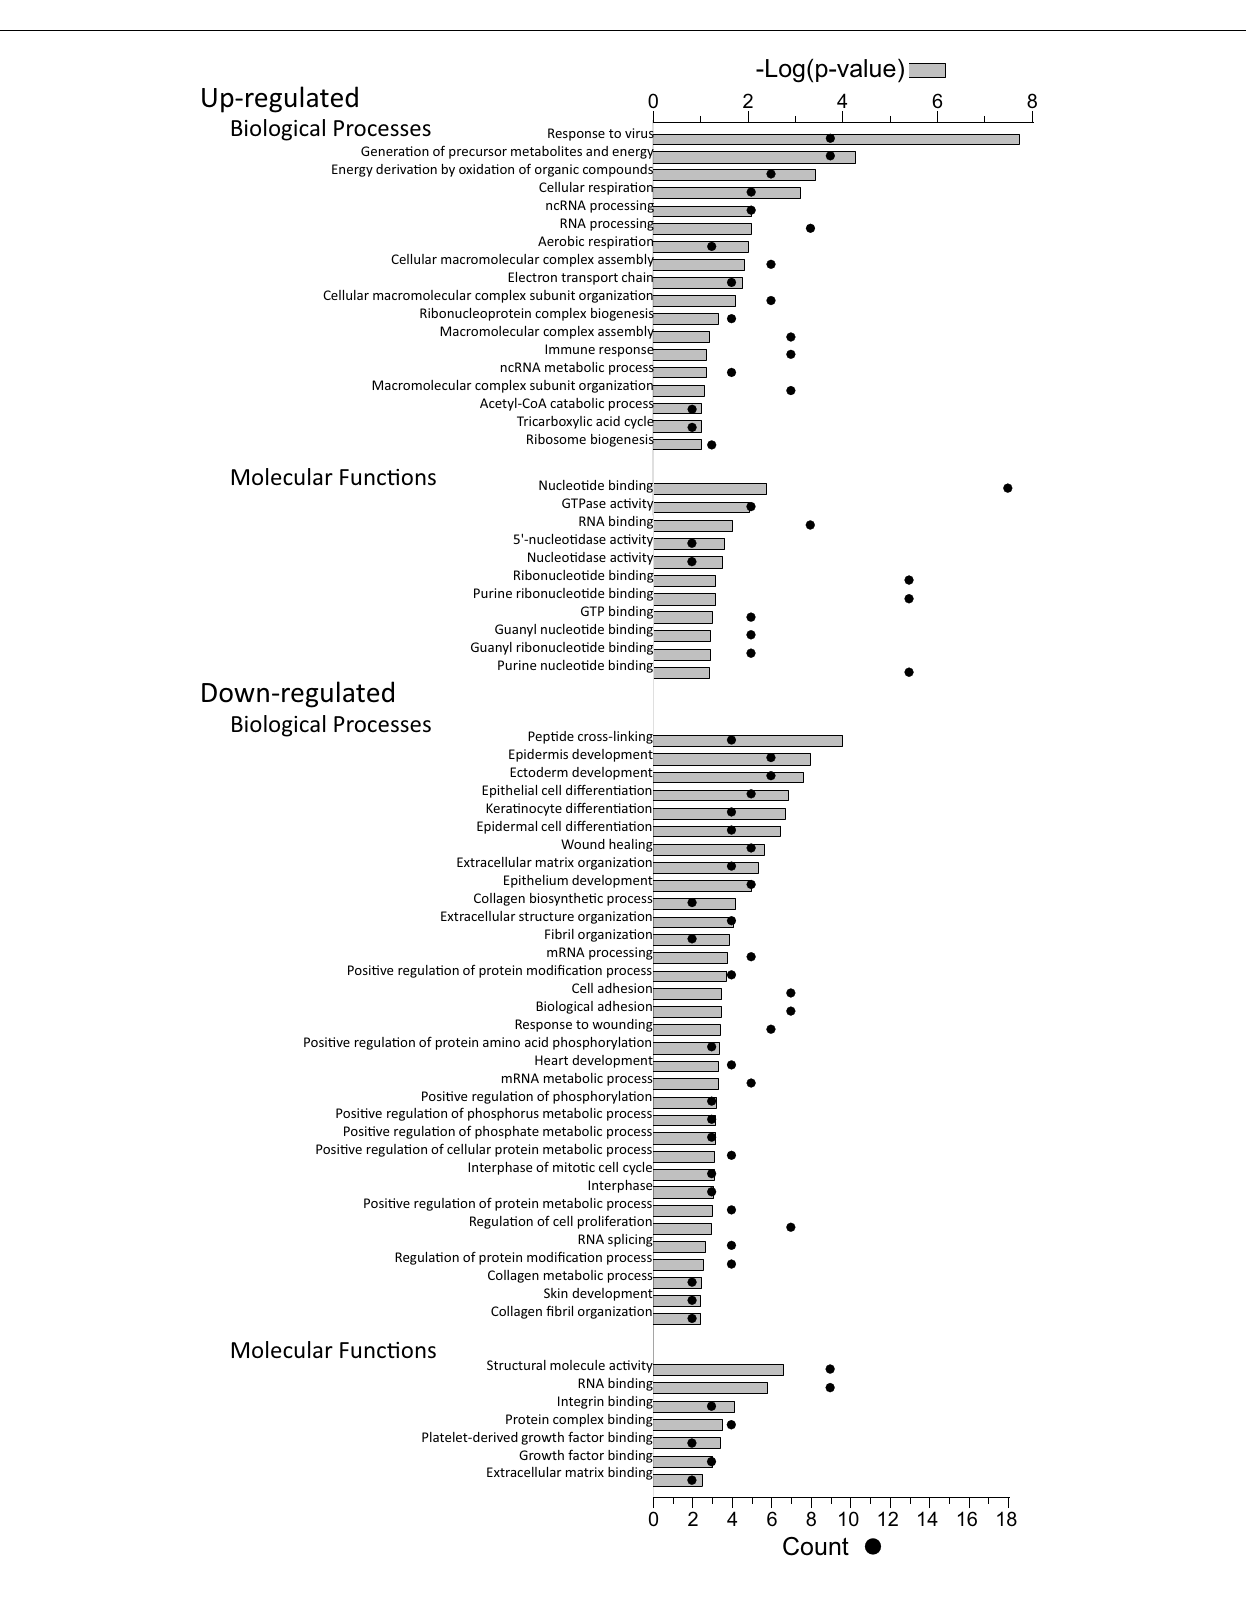
FIGURE 5 | Gene ontology analyses of up-regulated and down-regulated proteins. The proteins identified in Table 2 were imported into the DAVID